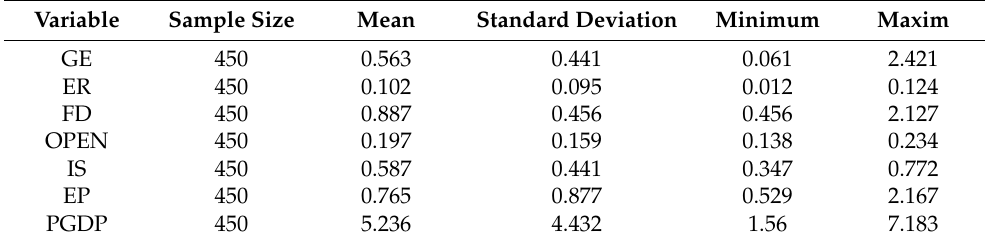
Table 1. Descriptive statistics of variables.